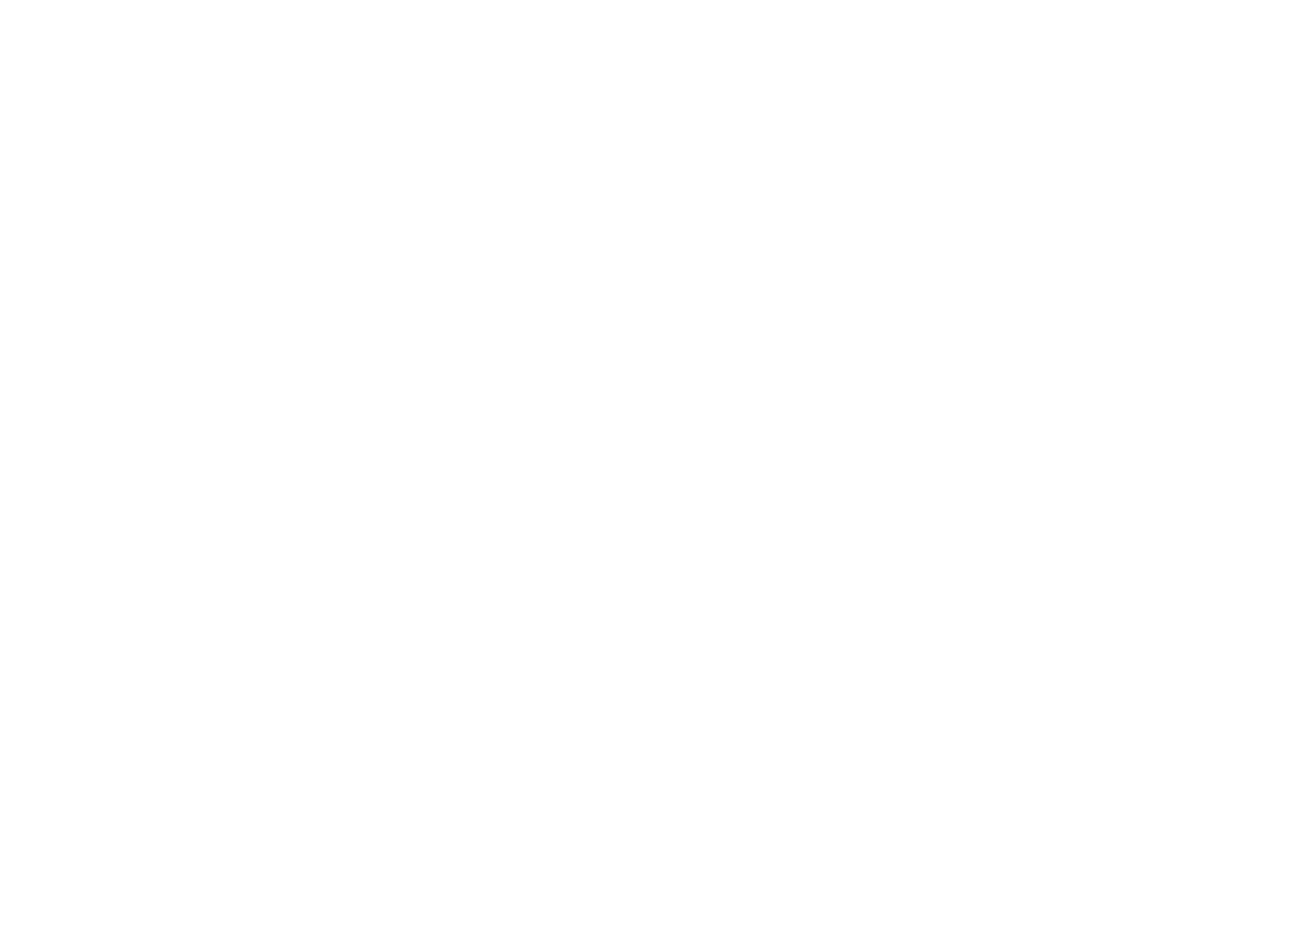
Frontiers in Physiology | Plant